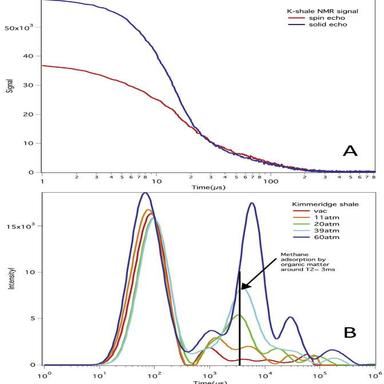
NMR signal decay of dry Kimmeridge Shale: A) comparing spin-echo and solid-echo response with a difference in intensity at T2 < 20 μs due to proton mobility at the surface of solid organic matter; B) NMR spin-echo relaxation distribution of Kimmeridge Shale under different pressures of methane gas injection up to 6 MPa. Note the gas adsorption occurring at T2 = 3 ms that is related to the signature of organic matter interactions with fluid(s).